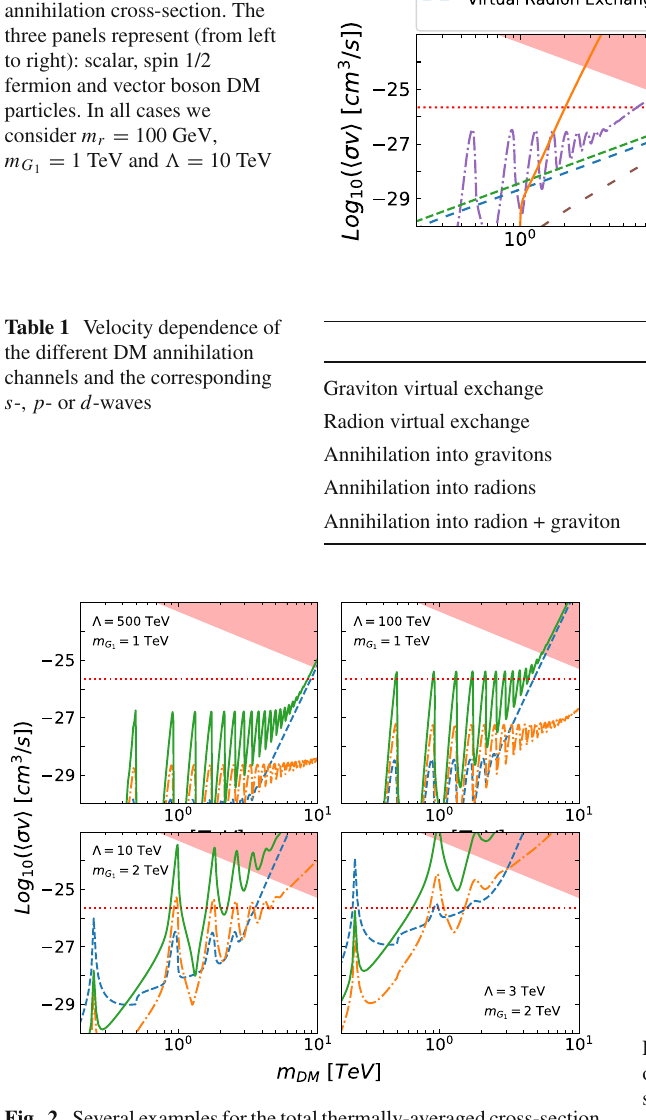
cross-section (cid:4) σ FO v (cid:5) and the region for which the effective field theory is not valid.